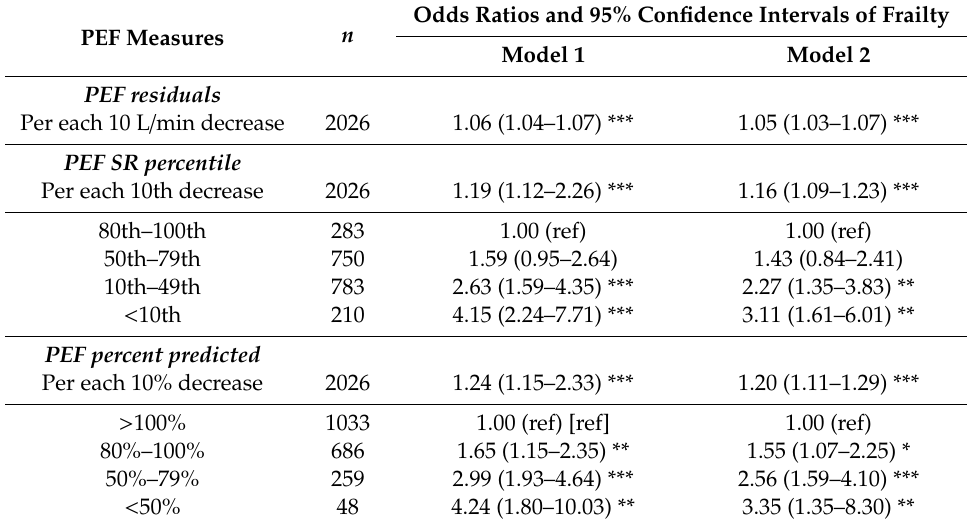
Table 3. Longitudinal association between peak expiratory flow and frailty over a 6-year follow-up. Odds Ratios and 95% Confidence Intervals of Frailty PEF Measures n Model 1 Model